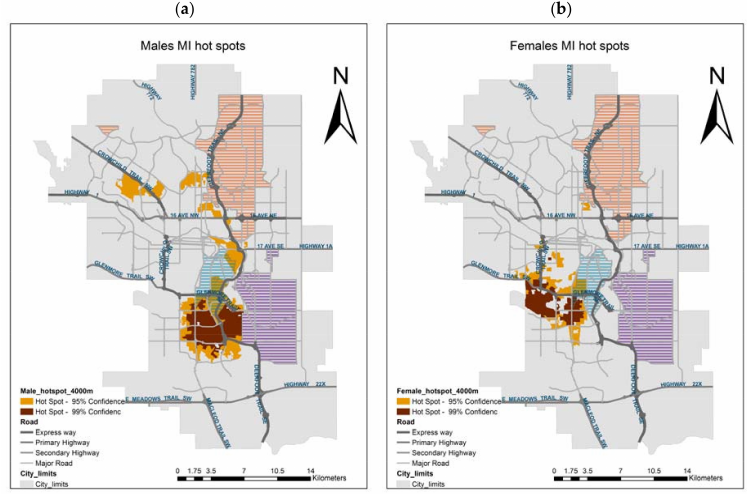
Figure 7. MI hot spots of ( a ) males, and ( b )